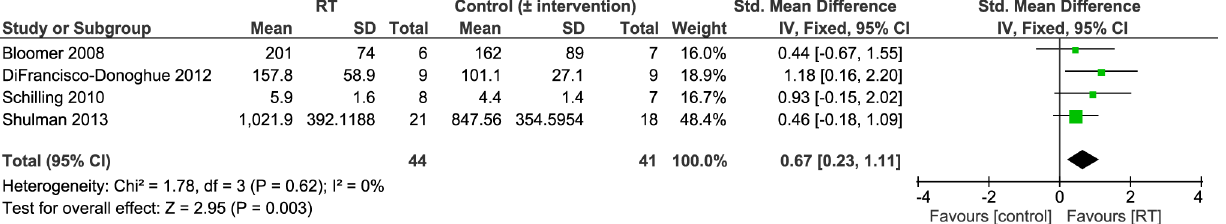
Fig 8. Primary analysis forest plot of comparison: RT vs. control-without/with-intervention, using post-intervention values, outcome: leg press strength. CI = confidence interval; IV = inverse variance; SMD = standardized mean difference.